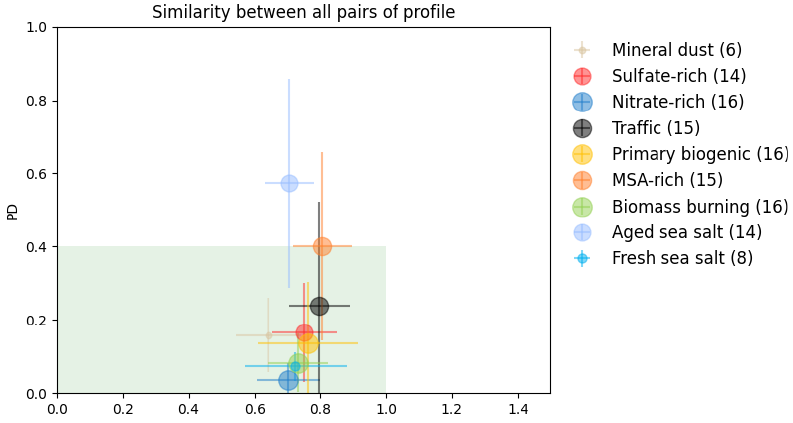
Figure 5. Similarity plot of the OPE site against all the French sites in the SOURCES programme. The shaded area (in green) shows the acceptable range of the PD-SID metric. For each point, the error bars represent the standard deviation in the comparisons of all pairs of sites. The number in the legend indicates the number of sites over France where the given profile is available.